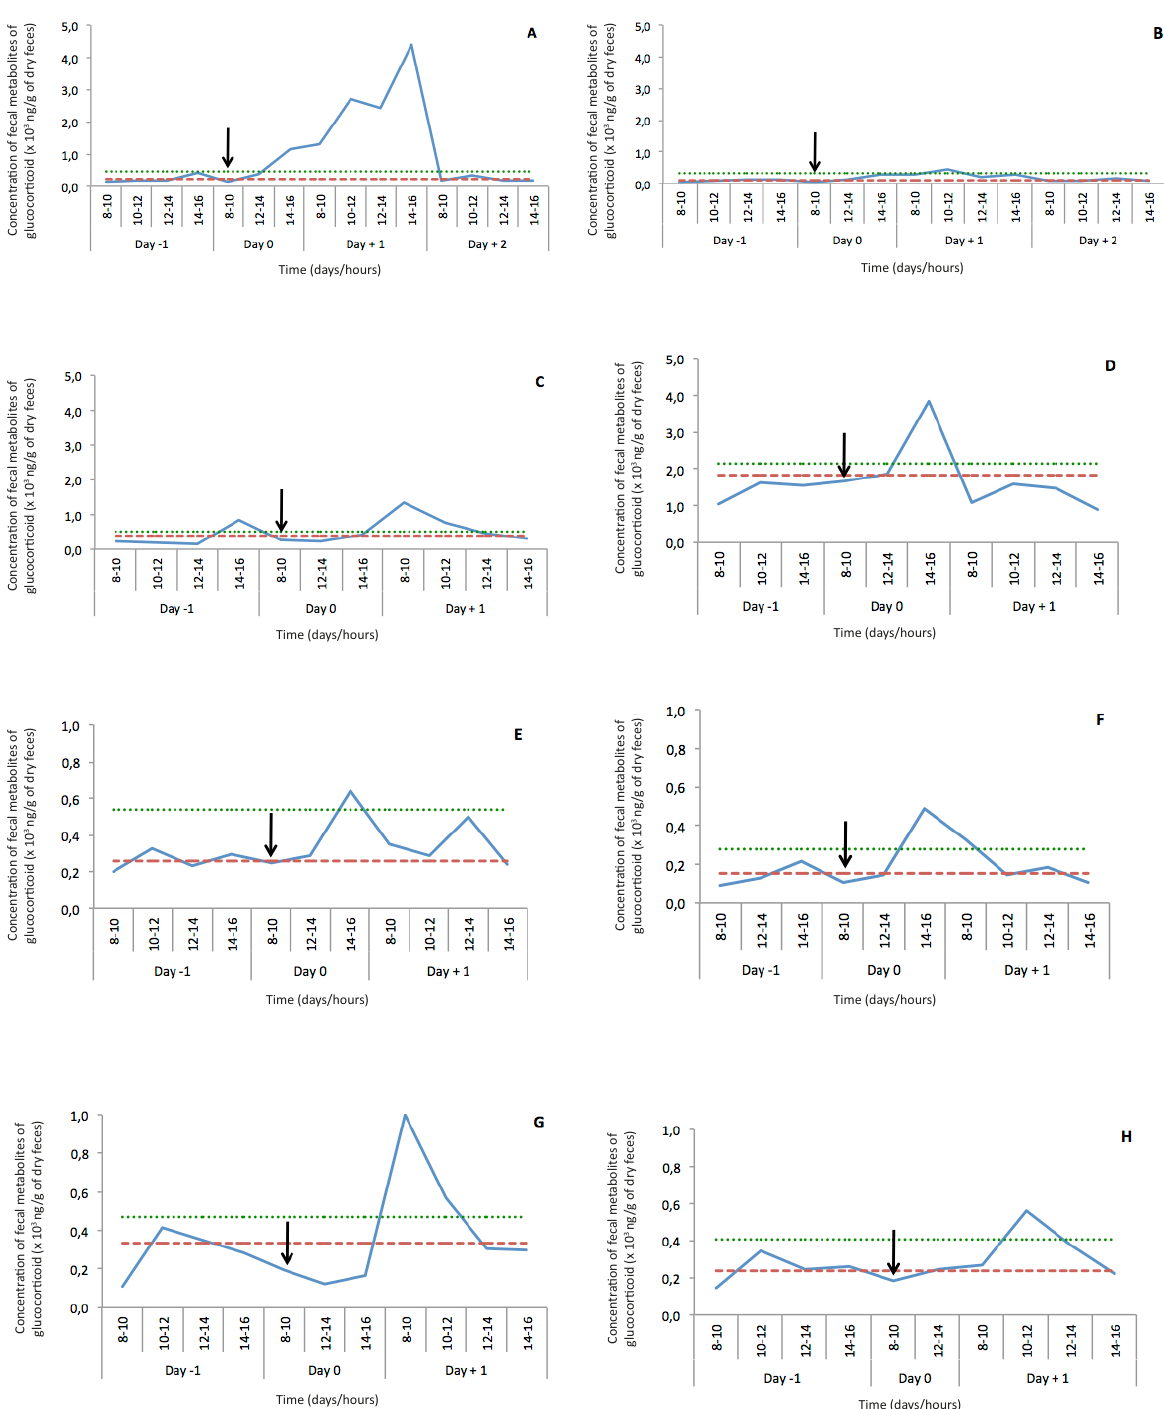
Figure 2. Concentrations of fecal glucocorticoids metabolites in males (A, B, C, D) and females (E, F, G, H) of Callithryx penicillata before and after saline solution injection (arrow); red dashed represent basal values; green dashed lines represent peak